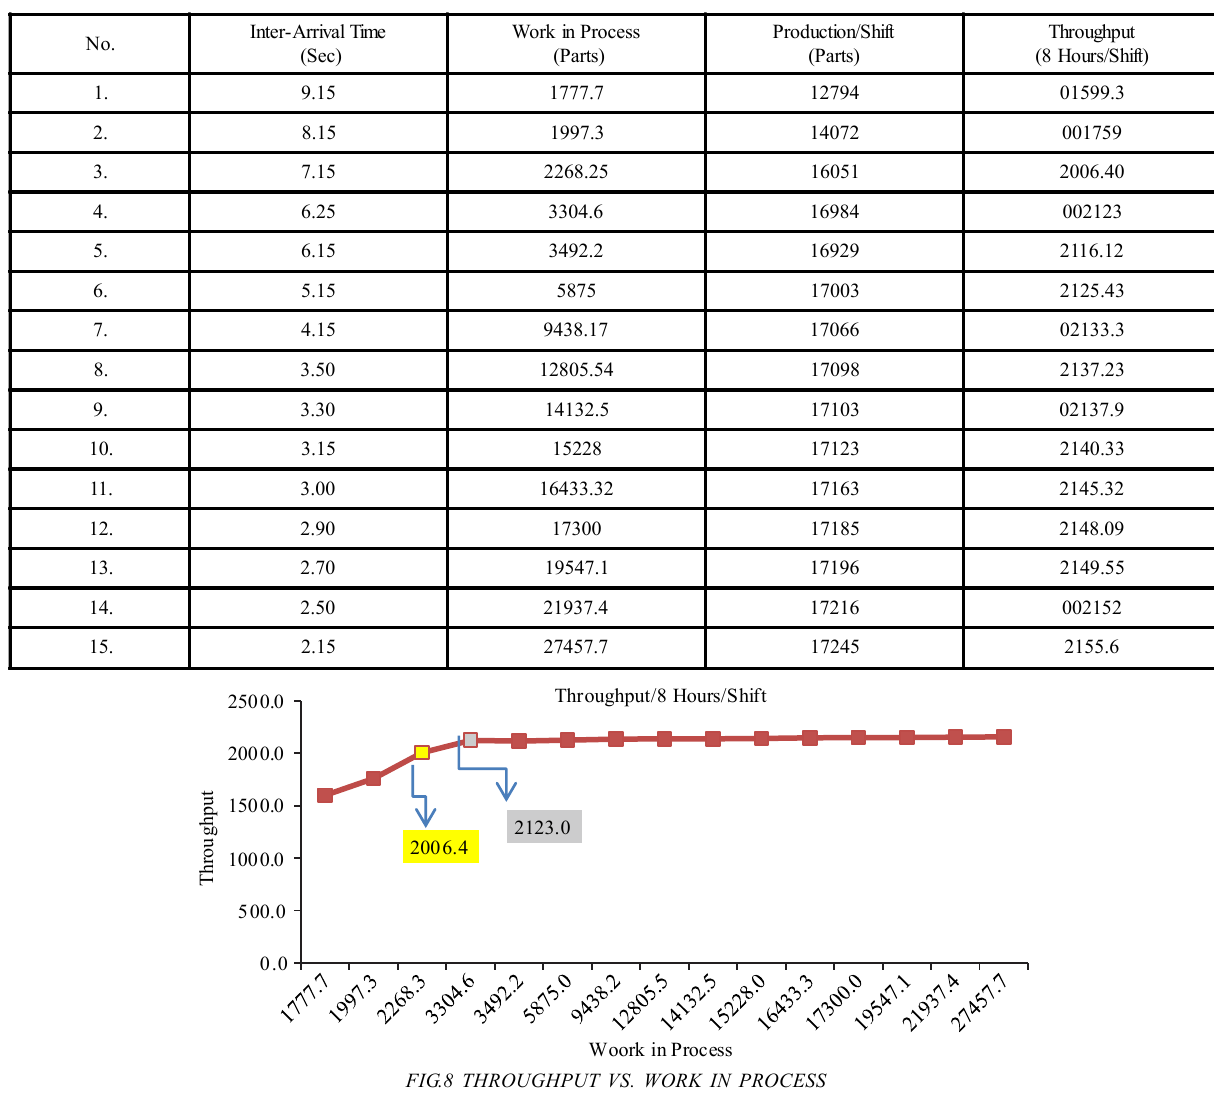
TABLE 10. RESULTS OF THROUGHPUT VS. WORK IN